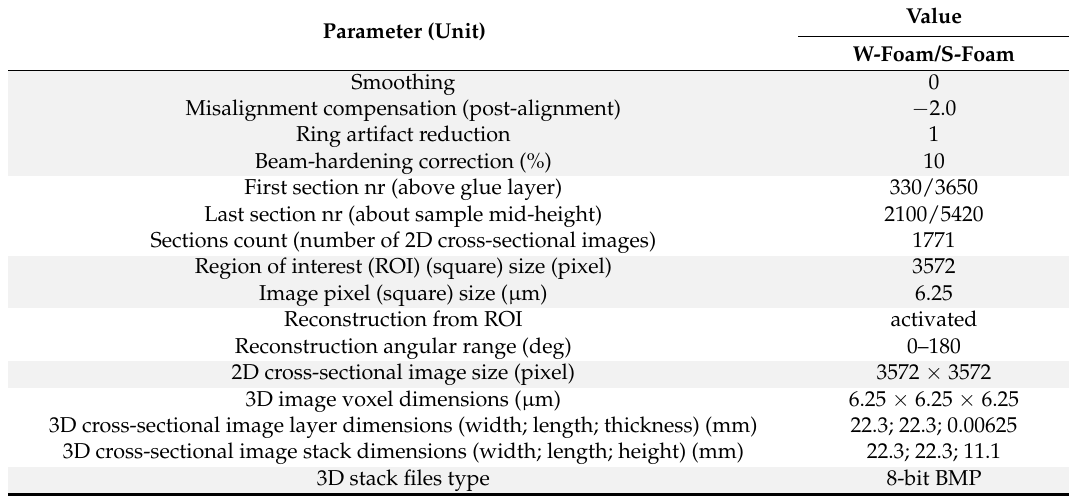
Table 6. The NRecon settings applied in the 3D image